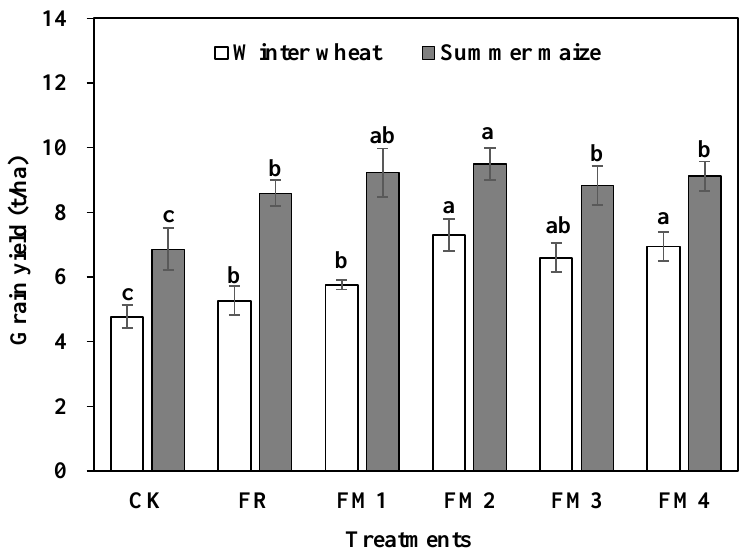
Figure 4. The oven-dried grain yields of wheat and maize under different experimental treatments after four years. Different lowercase letters in the same box denote significant differences at p < 0.05,